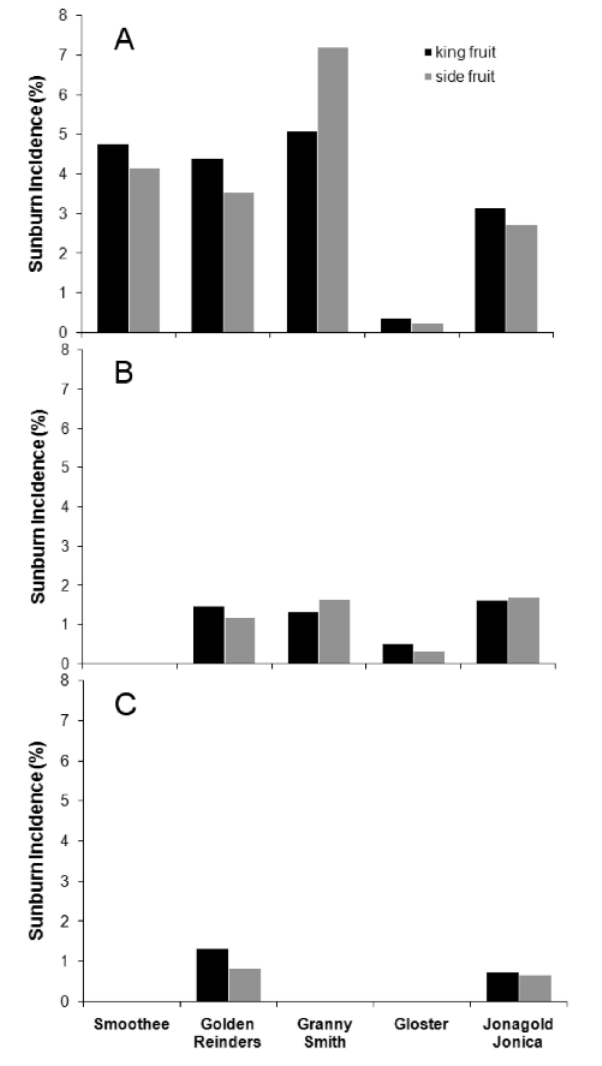
Fig. 5. Percentage of fruit affected by sunburn in terminal or lateral position of the cluster on M.9 (A), MM.106 (B) and seedling (C) rootstocks at harvest. Data are based on the average of 2006 and 2007. No significant difference was found in sunburn incidence between king and side fruit on all rootstock-cultivar